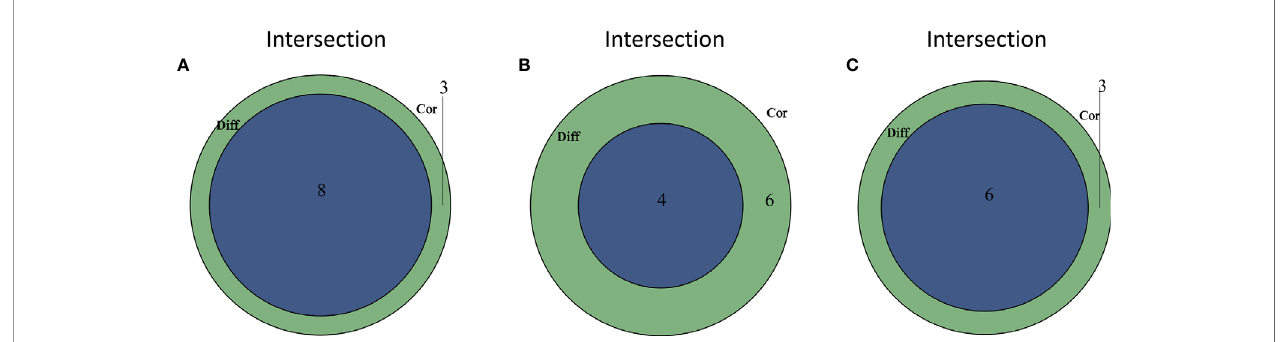
FIGURE 9 | TICs related to the expression of C1qA, C1qB or C1qC. (A) Venn diagram showing the 8 TICs related to C1qA expression. (B) Four TICs related to C1qB expression. (C) Six TICs related to C1qC expression. These TICs were determined jointly from the differences and correlation tests shown by the violin and